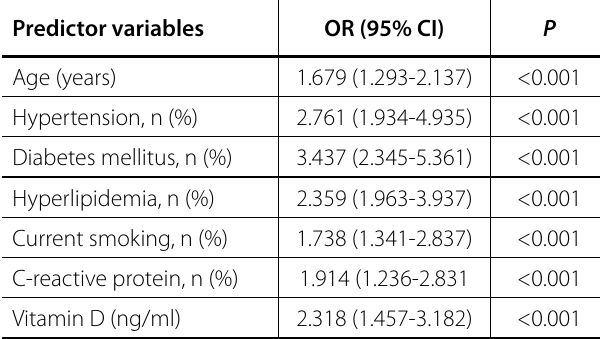
Table 3. Univariate analysis of predictors of high SYNTAX score. Predictor variables